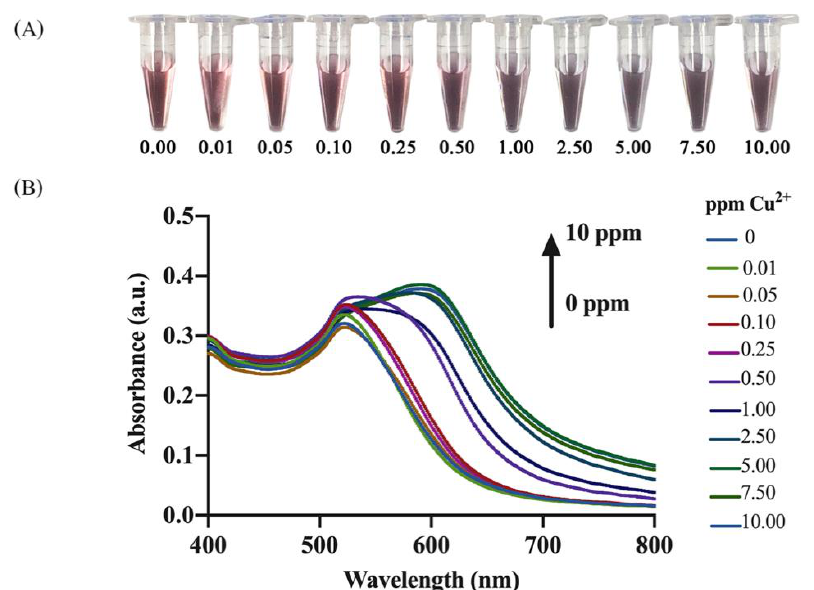
Figure 4. ( A ) Photographs of the Thy-AuNP-AgNP sensing solutions with various Cu 2+ concentra- tions (0.00, 0.01, 0.05, 0.10, 0.25, 0.50, 1.00, 2.50, 5.00, 7.50 and 10.00 ppm) and ( B ) the corresponding absorption spectra.